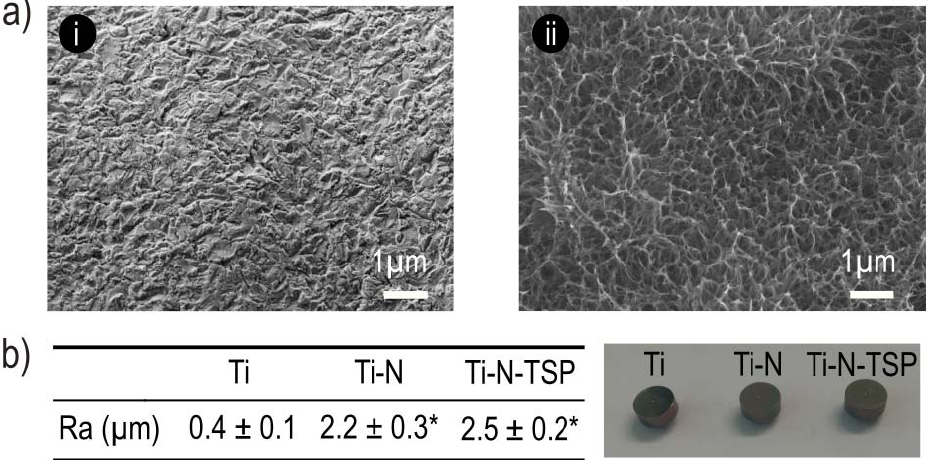
Figure 2. ( a ) Representative scanning electron microscopy (SEM) images of titanium dental implants (i) non ‐ activated titanium dental implant (Ti) and (ii) titanium dental implant thermochemical treated with NaOH 5M (24 h treatment, 60 °C) (Ti–N). ( b ) Ra values for each treatment and samples images. * indicates statistically significant differences compared to Ti (p < 0.05).